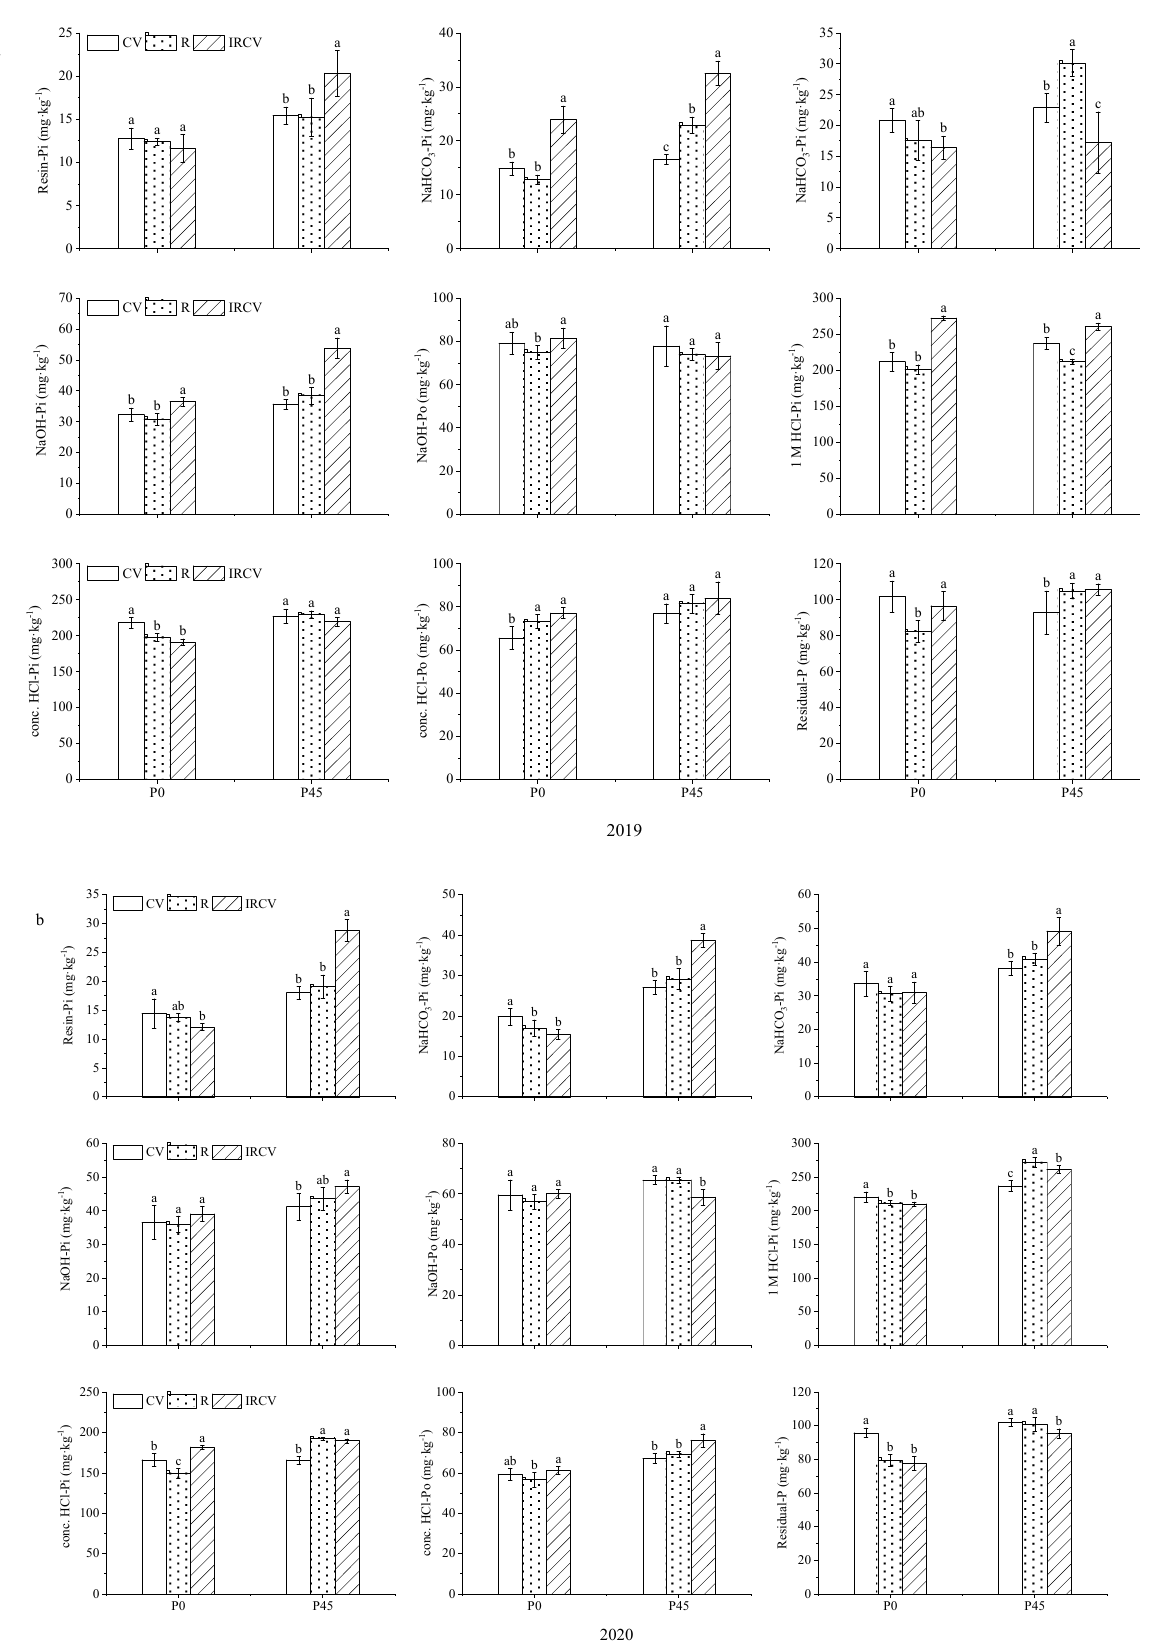
Figure 4. Comparisons of P fraction in different cropping patterns at two P levels in 2019 ( a ) and 2020 ( b ).